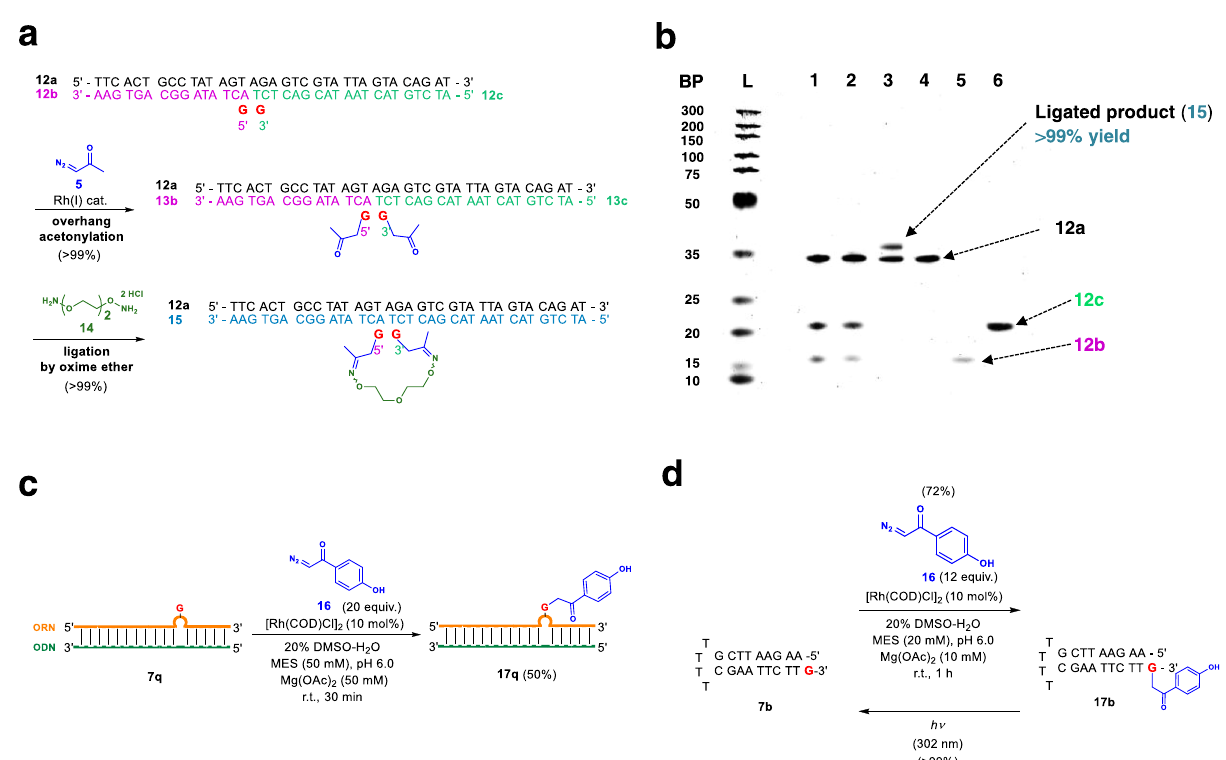
Fig. 6 Chemical ligation of oligodeoxynucleotides and single-step synthesis of photocaged oligonucleotides. a Synthetic scheme for the ligation of oligonucleotides with an oxime ether linker. b Denaturing PAGE analysis of the ligation visualized by SYBR gold. Lanes; L: DNA ladder, 1: before acetonylation, 2: after acetonylation, 3: after ligation, 4: 12a , 5: 12b , 6: 12c . c Synthesis of photocaged single-stranded oligoribonucleotide based on the